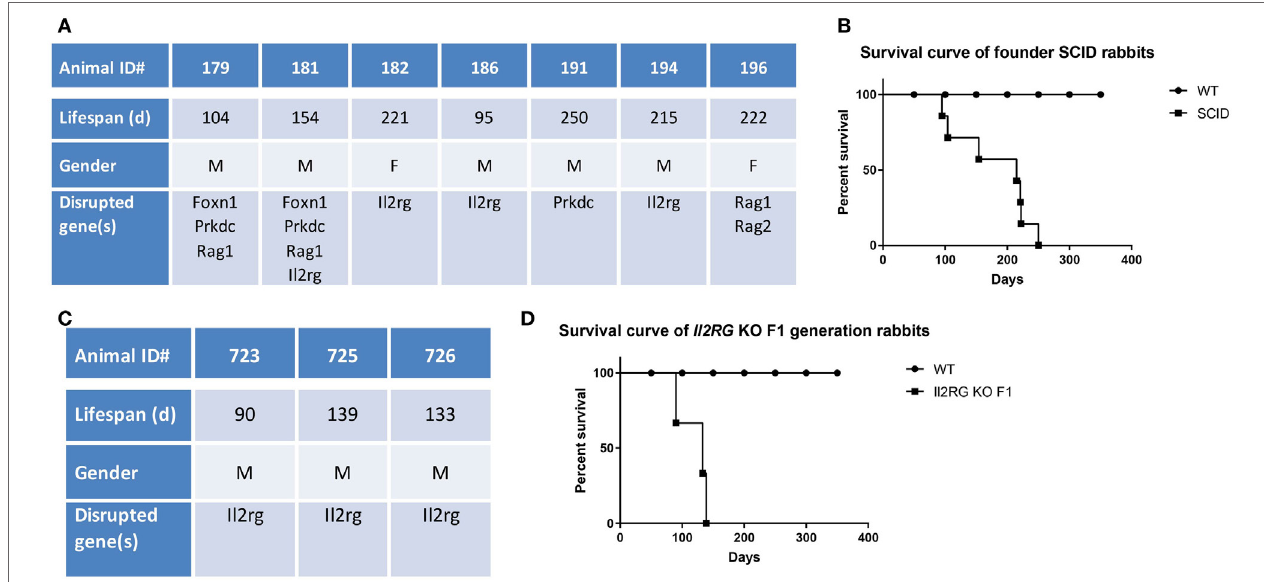
FigUre 1 | Lifespan of severe combined immunodeficiency (SCID) rabbits. (a) Summary of founder (F0) SCID rabbits. (B) Survival curve of Founder SCID rabbits. (c) Summary of F1 IL2RG-KO (X-SCID) rabbits. (D) Survival curve of F1 IL2RG-KO (X-SCID)